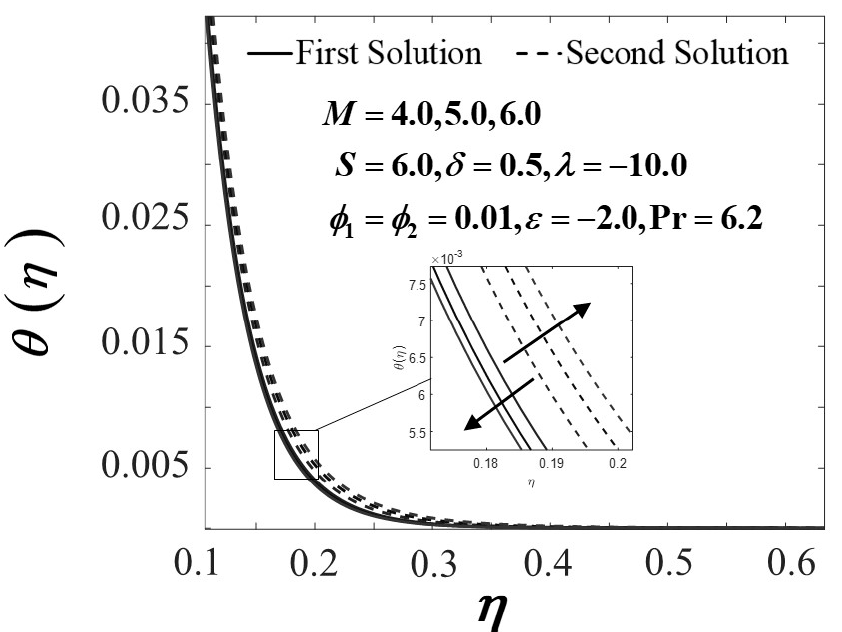
( ) θ η ( η ) with various M when λ = − with various M when 10.0 λ= − . Figure 9. θ